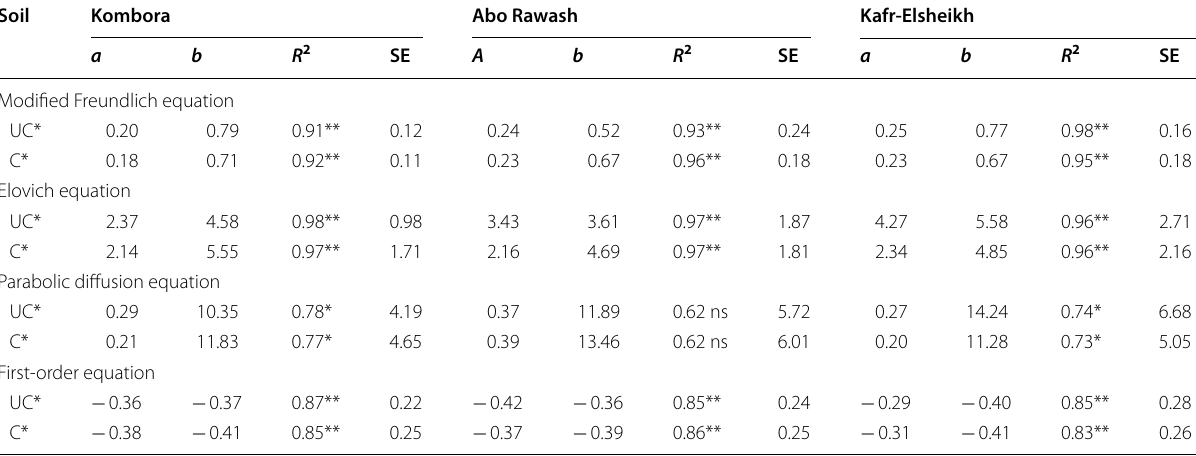
UC uncultivated soil, C cultivated